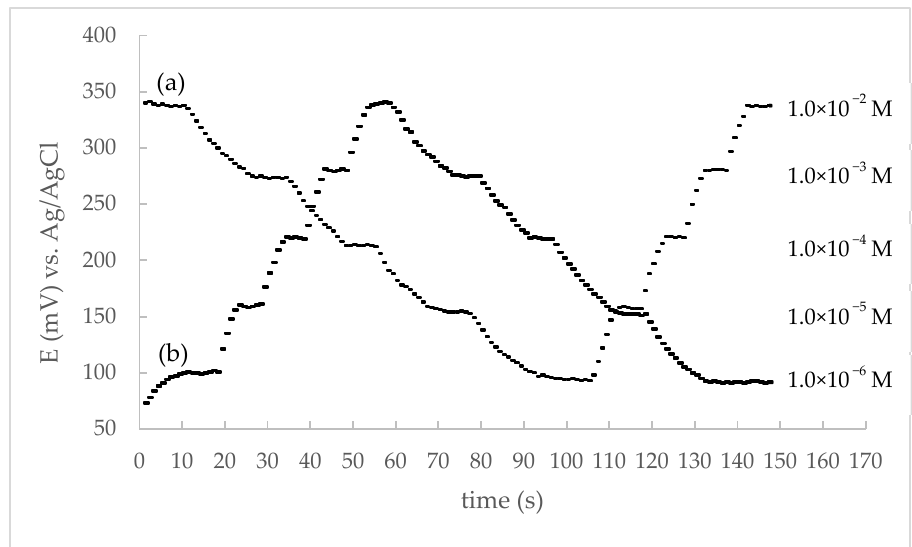
Figure 4. Dynamic response time and reversibility of proposed CPE ( a )-descending and then ascending order, ( b ) ascending and then descending order of MAP concentration).